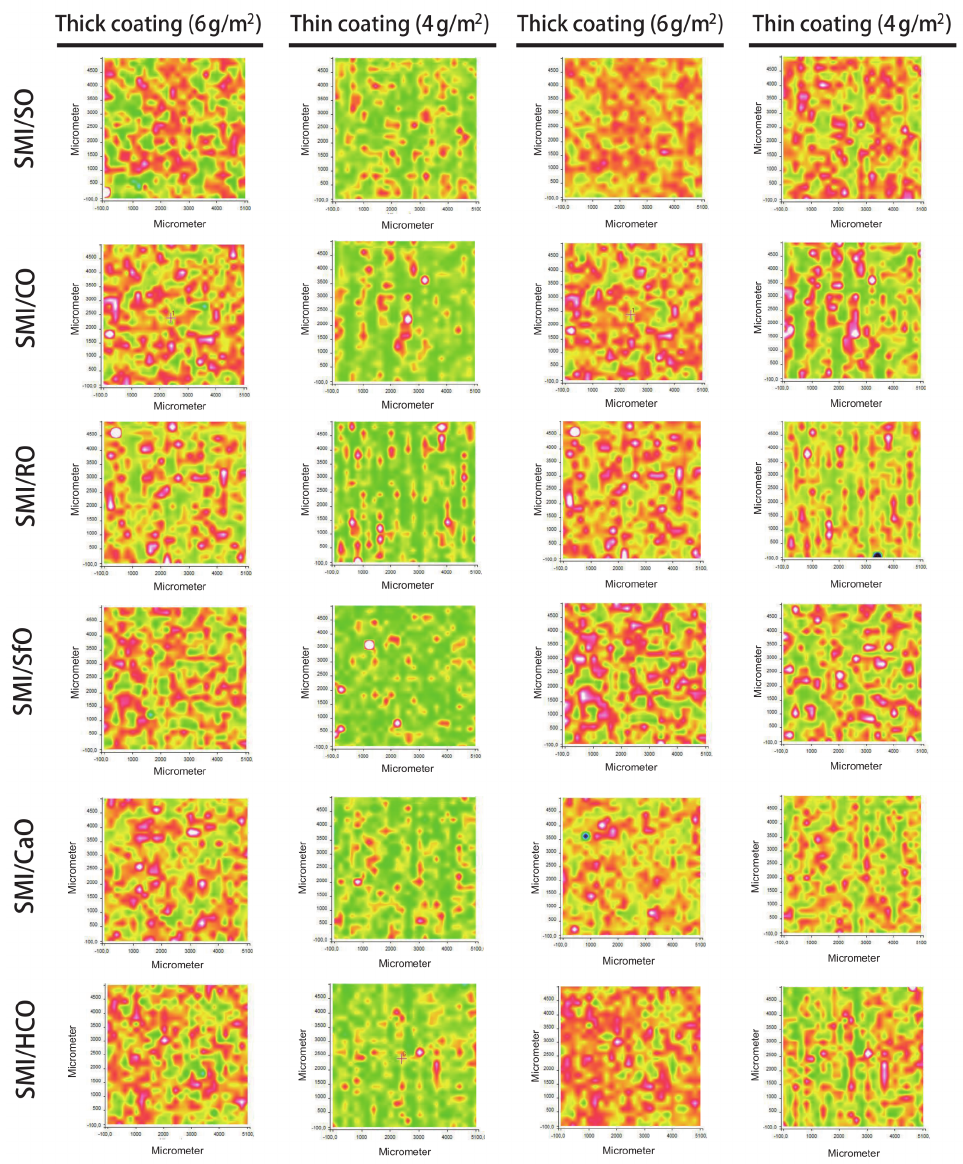
Figure 8. Raman maps (5 × 5 mm 2 ) with band intensity ratios illustrating styrene moieties at the surface for SMI/oil paper coatings (left two columns: 1602 cm − 1 /cellulose, right two columns: 1000 cm − 1